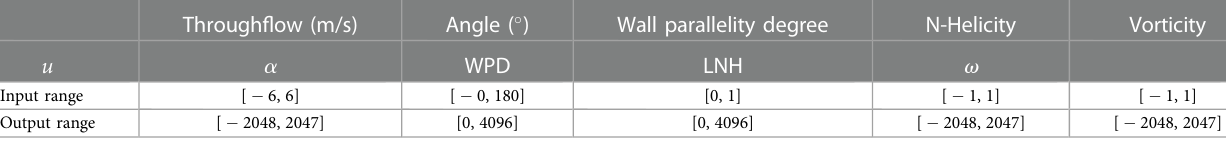
TABLE 2 Radiomics features were extracted with a fi xed bin width 25 (default setting of the pyradiomics library). Each feature map had to be rescaled to enable a robust extraction of the parameters. Input value ranges of the through fl ow, angle, wall parallelity degree, normalized helicity and vorticity feature maps are given in the fi rst row. They are mapped to the output ranges shown in the second row.